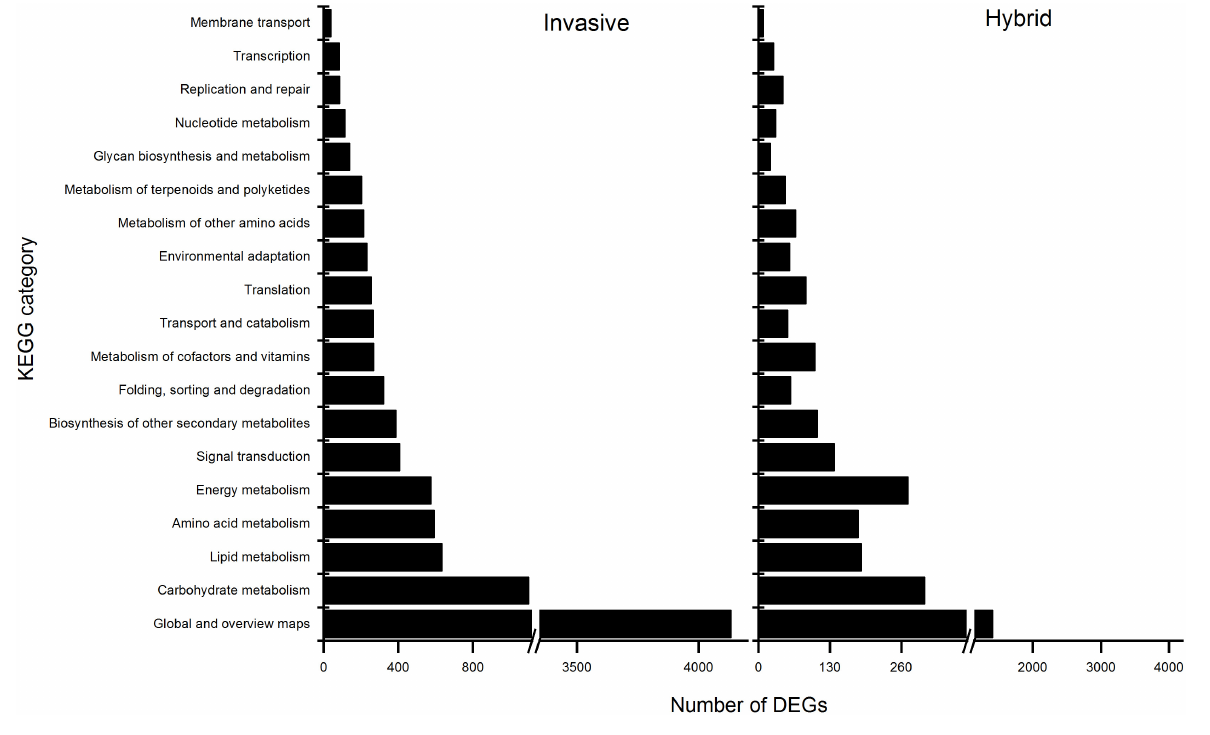
Frontiers in Plant Science |